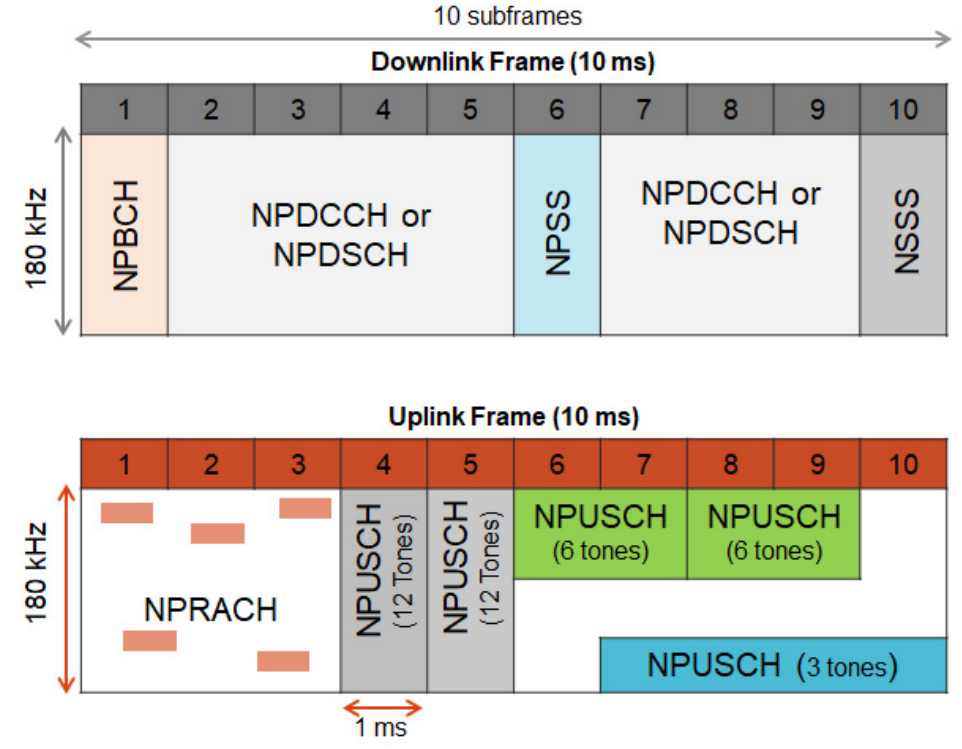
Figure 1. A representation of the NB-IoT uplink and downlink frames structure considering 15 kHz subcarrier spacing in